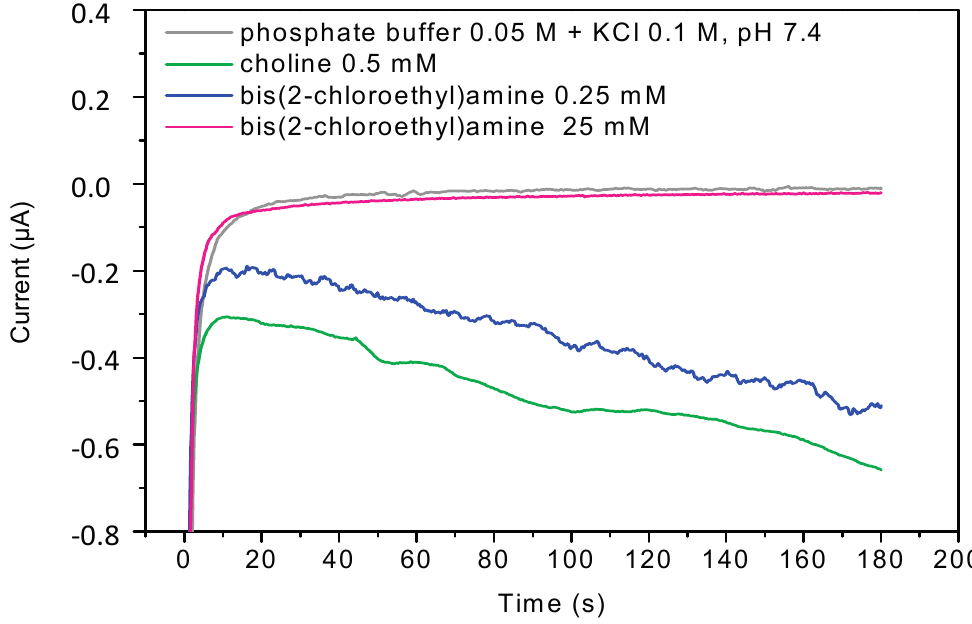
Figure 4. Original recording obtained using the bioassay . Applied potential − 50 mV vs. Ag/AgCl; Choline oxidase concentration: 180 mU/mL. Signal recorded in 0.05 M phosphate buffer solution + 0.1 M KCl, pH 7.4 (grey line) and in a solution of choline (0.5 mM) in 0.05 M phosphate buffer solution + 0.1 M KCl, pH 7.4 in absence (green line) and in presence of bis(2-chloroethyl)amine 0.25 mM (blue line) and 25 mM (pink